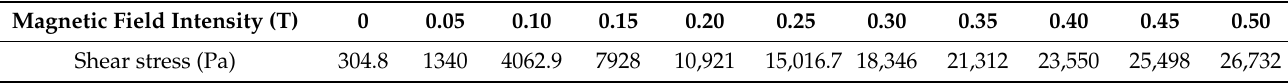
Table 2. Shear stress of the MRF under different magnetic fields.